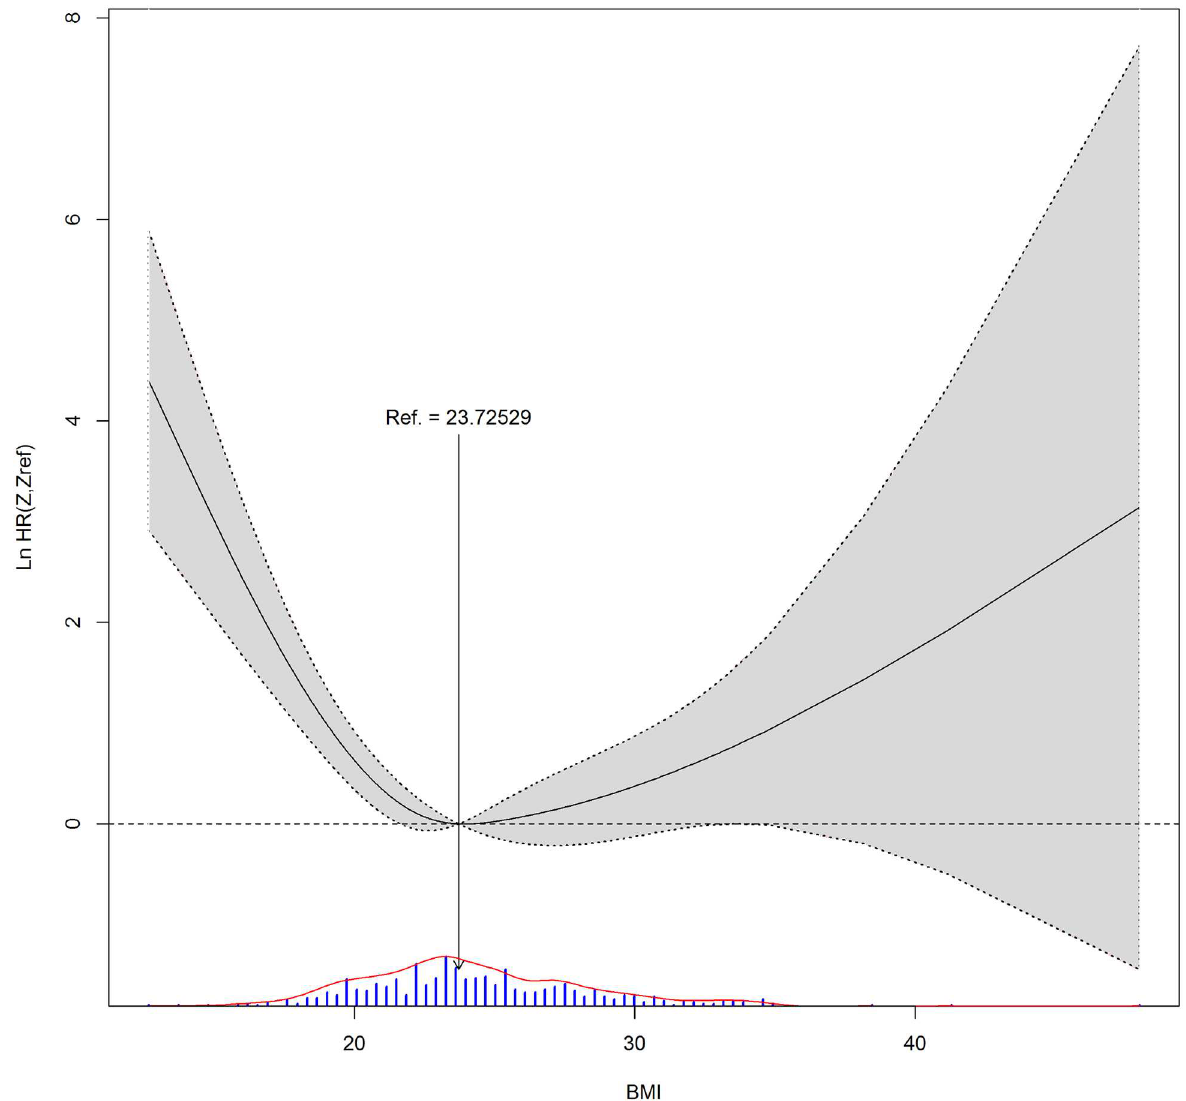
Fig 2. BMI distribution against hazard ratio (HR) in the event of death. Arrow marks position of the lowest HR. BMI histogram is illustratedwith bars at the bottom of the figure.